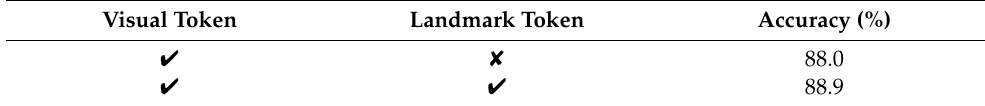
Table 1. Ablation study of tokens for each configuration on the RAF-DB dataset.